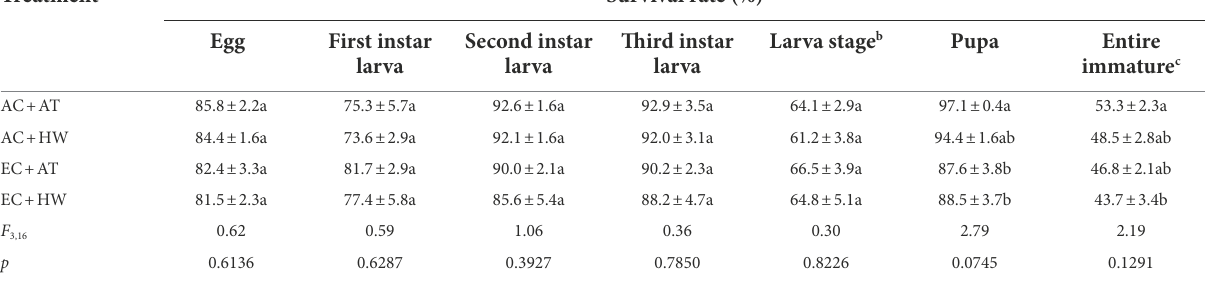
TABLE 3 Effect on survival of Ophraella communa after feeding on common ragweed grown under different treatment conditions. Treatment